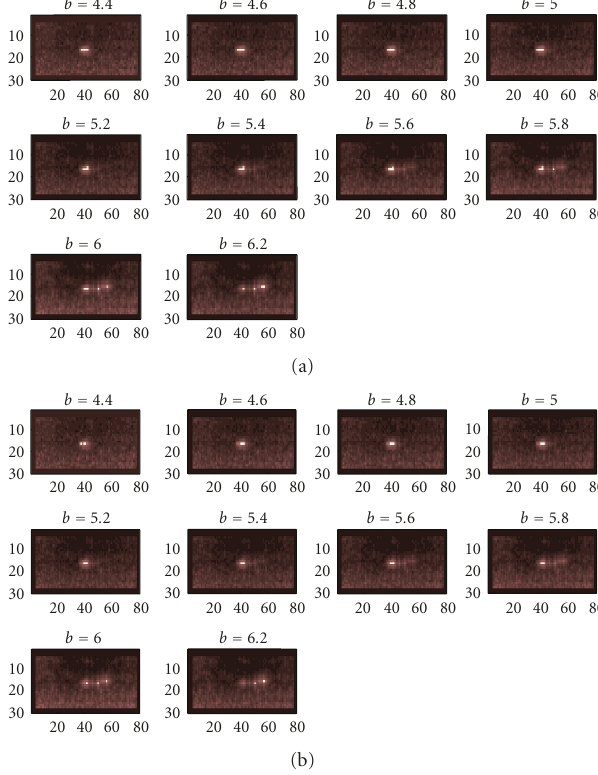
Figure 17: NA23A sequence, s n = 4, last processed frame. (a) Highest 5 pixels emphasized and (b) highest 3 pixels